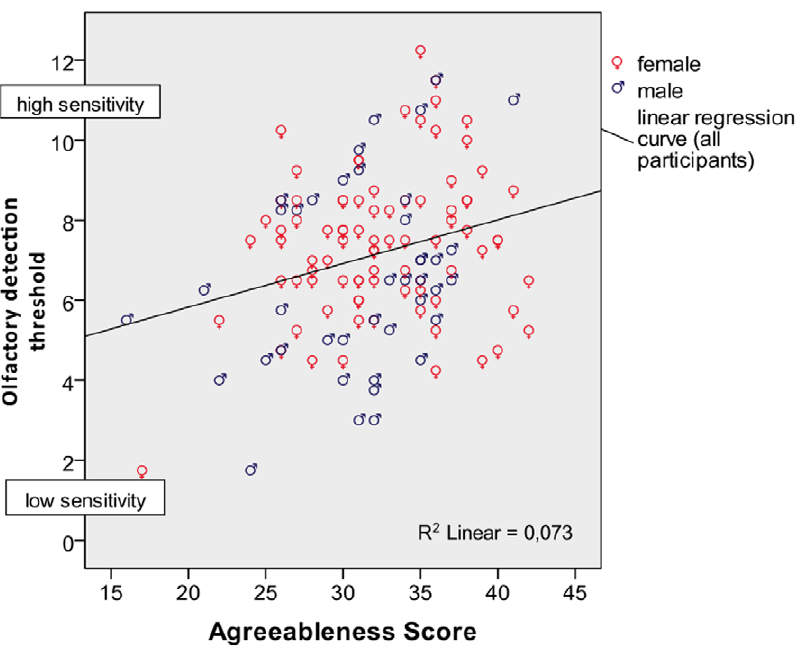
Figure 1. Odor detection threshold and agreeableness scores in male and female participants.